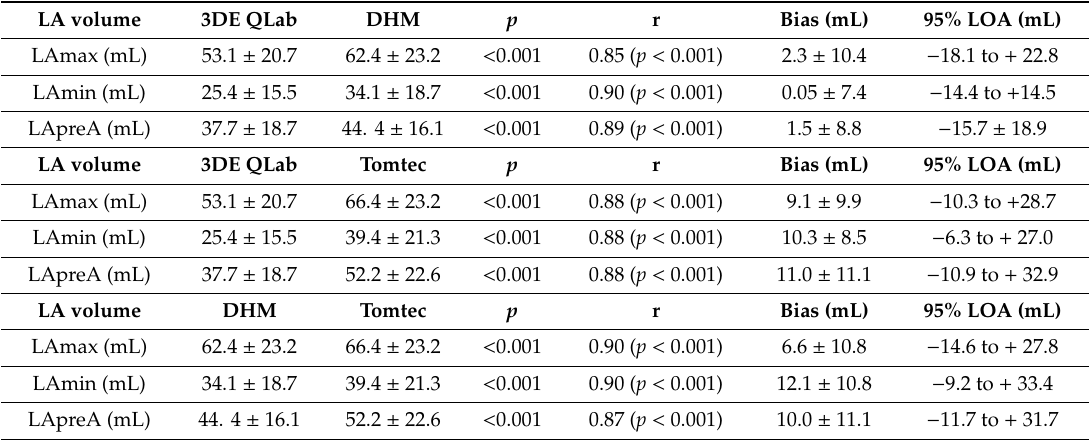
Table 2. Comparison between di ff erent three-dimensional echocardiographic modalities.